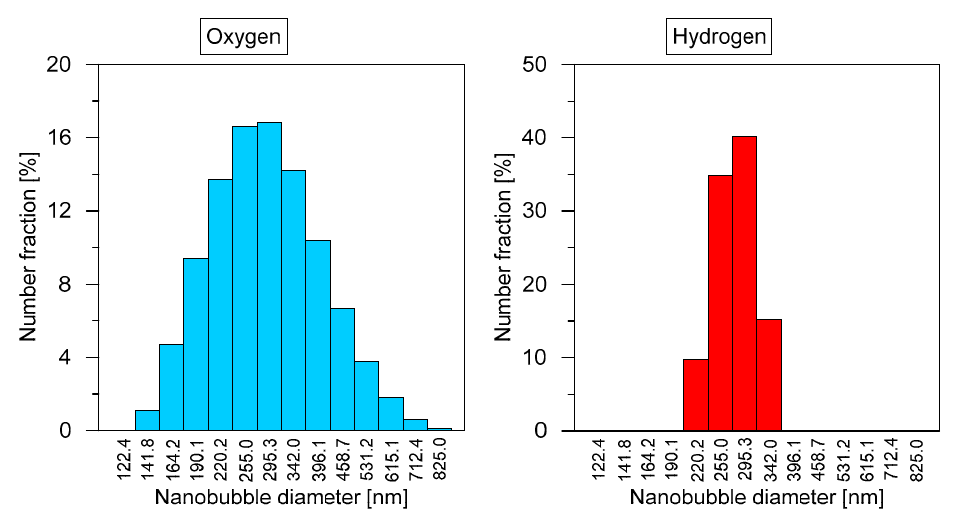
Figure 2. Exemplary densities of size distributions of nanobubbles of oxygen ( left ) and hydrogen ( right ). As it is shown, the nanobubbles are generated depending on the set of values of in- and a statistical model was proposed.